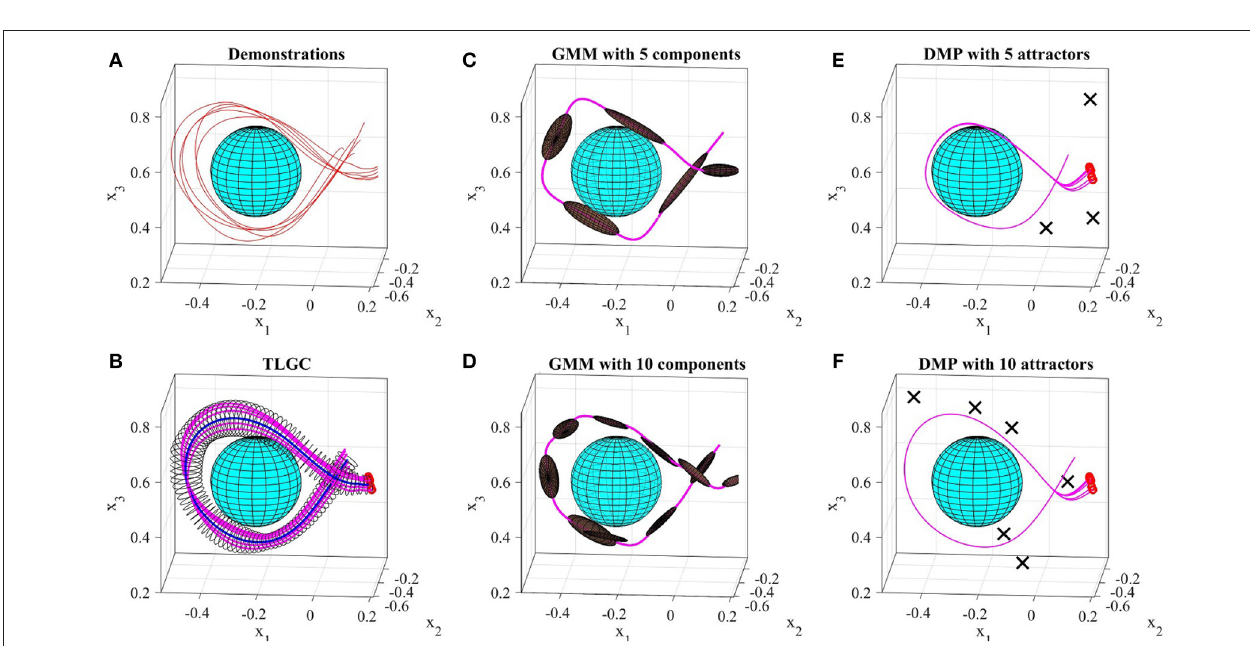
FIGURE 11 | Results of the comparison between GMM, DMPs, and TLGC in section 5.3.1 (A) demonstrations (B–D) GMM with two, four, and eight components respectively, (E) generalized cylinder and ten reproductions (F–H) DMPs with two, four, and eight attractors and 10 reproductions, respectively.